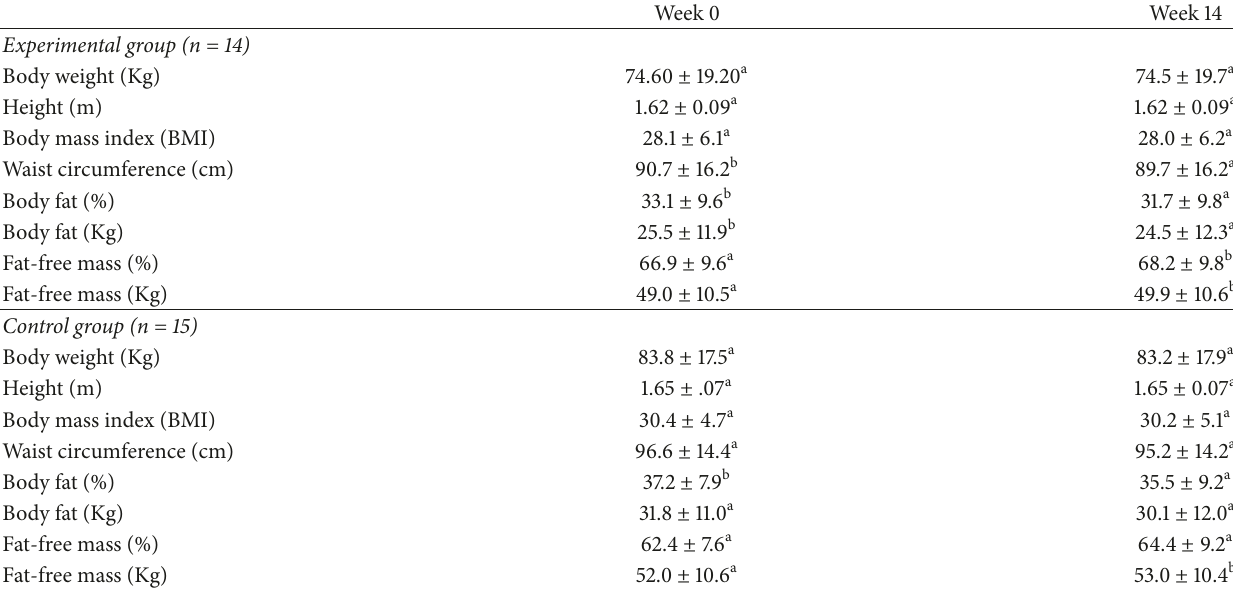
Table 1: Anthropometric parameters of experimental and control